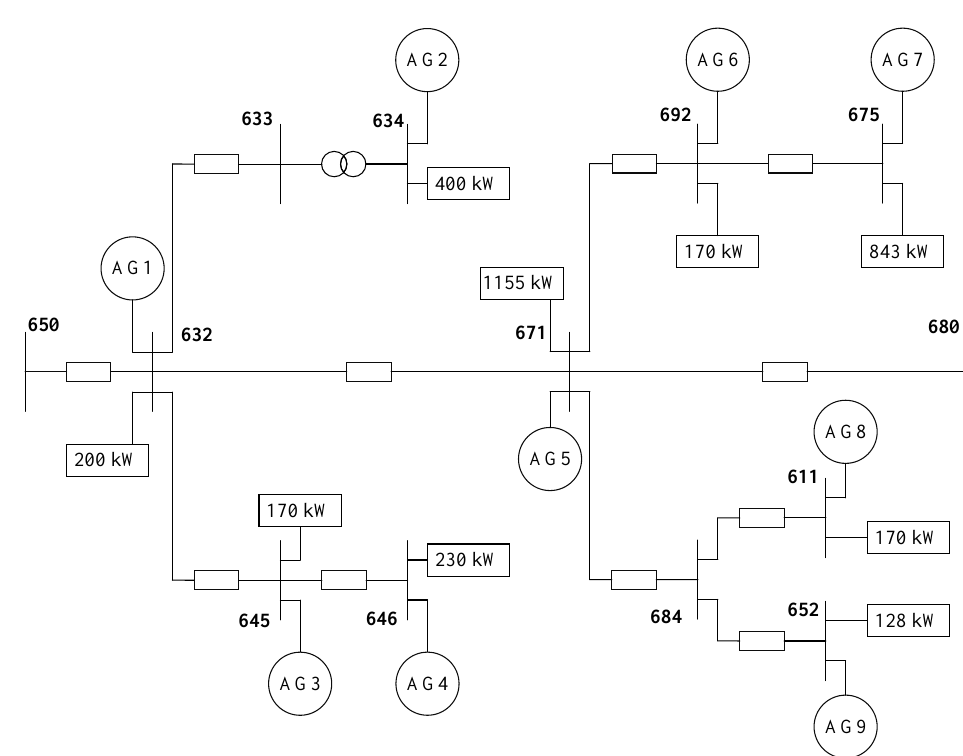
Figure 3. IEEE 13-node feeder configuration.